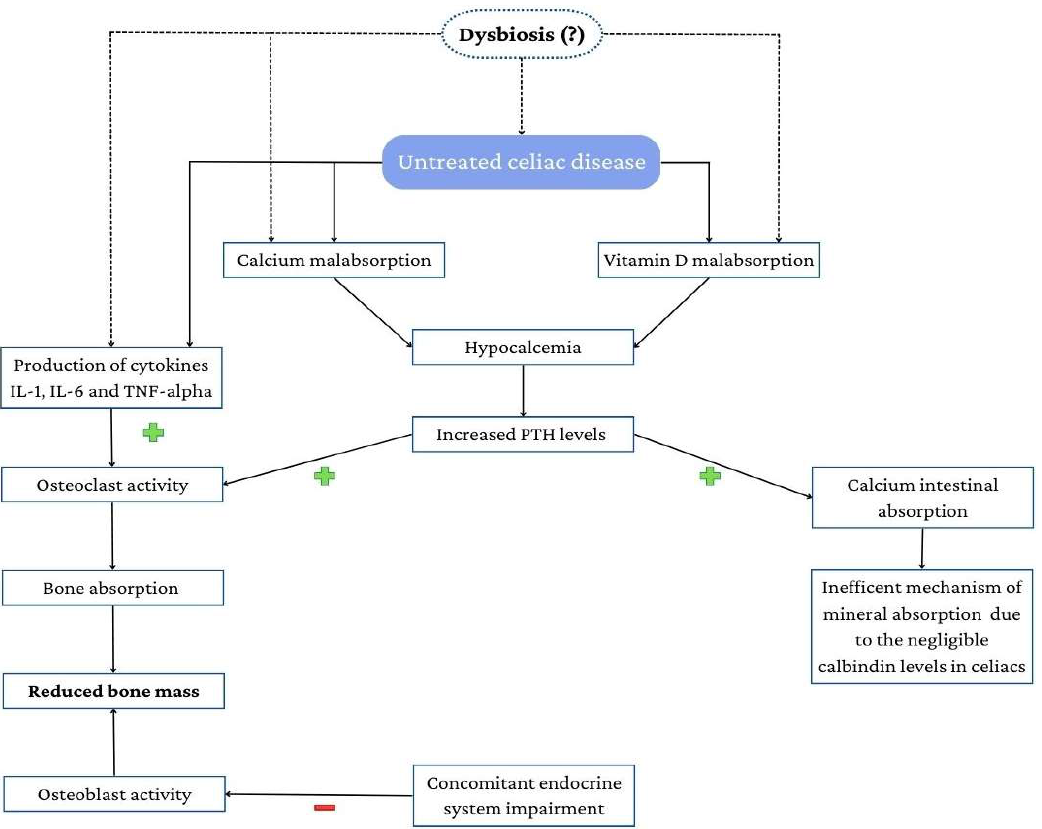
Figure 1. Possible mechanisms involved in bone demineralization in CD. The presence of dysbiosis alone, even in the absence of villous atrophy, can induce calcium and vitamin D malabsorption.